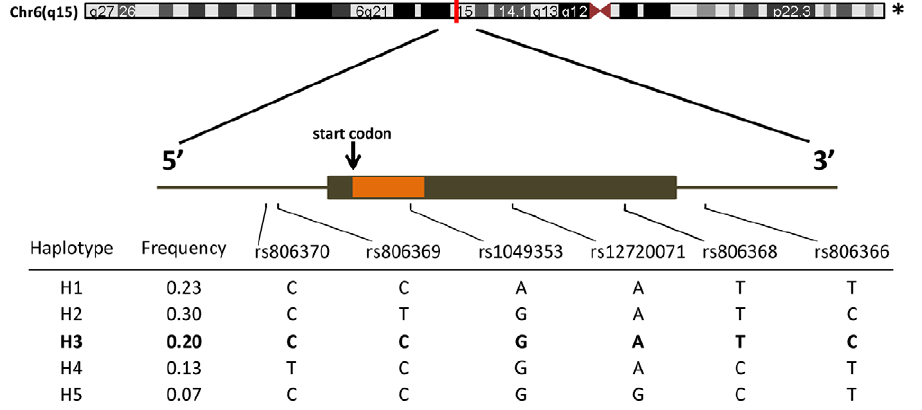
Figure 1. The CNR1 gene: chromosomal location, tagSNPs, haplotype structure and alleles. *The CNR1 gene locus covers , 15 kb on Chromosome 6 (chromosome 6 is shown in the reverse orientation, with arm q on the left). Six haplotype tagging SNPs were genotyped, based upon our prior work [25], and reference sequence numbers for the tag SNPs are presented. These SNPs are inherited in combination (haplotypes).